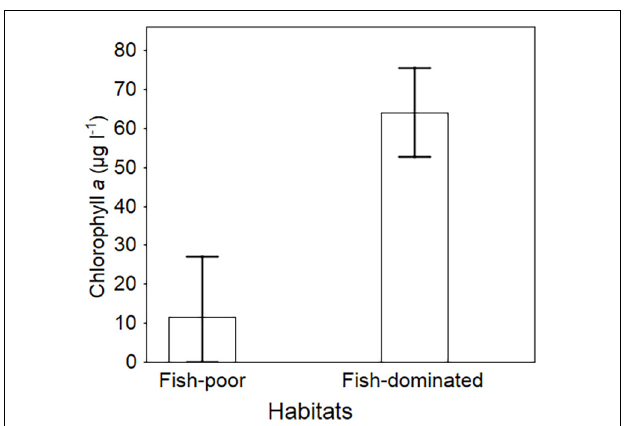
FIGURE 5 | Residual maximum likelihood (REML)-predicted mean ( ± SE) chlorophyll a concentrations in fish-poor and fish-dominated ponds.